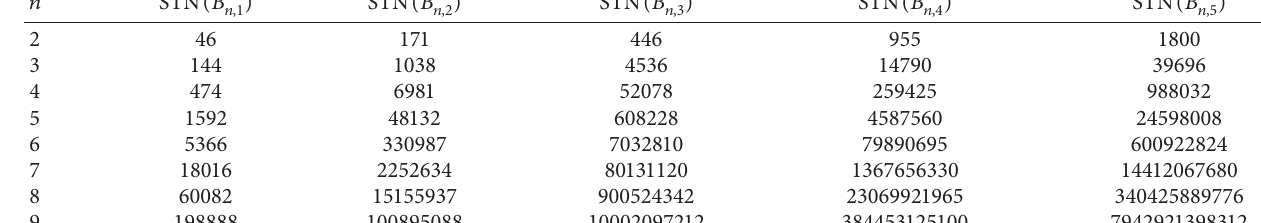
( k � 1 , 2 , .. . , 5 ; n � 2 , 3 , ... , 11 ) . n,k